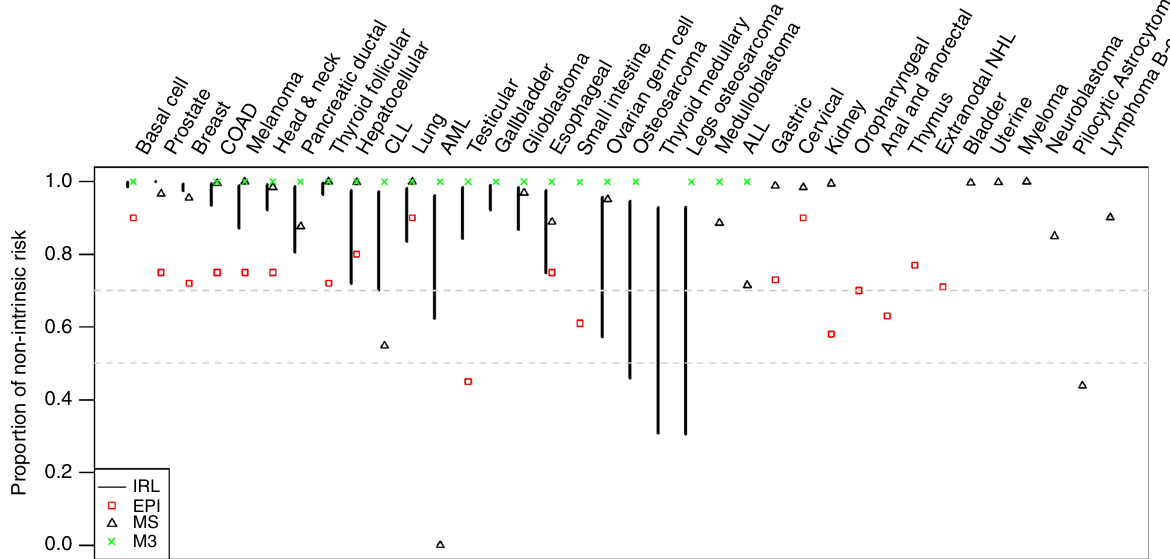
Fig. 4 Proportion of non-intrinsic risk estimates from four different approaches. Data were obtained from ref 15 . The two dashed horizontal lines indicate non-intrinsic risk at the levels of 0.5 and 0.7. IRL con fi dence interval from the intrinsic risk line method, EPI epidemiological estimates, MS estimates based on mutational signatures (Box 1), M3 estimates from the 3-hit model, AML: Acute Myeloid Leukemia, ALL: Acute Lymphocytic Leukemia, CLL: Chronic Lymphocytic Leukemia, NHL: Non-Hodgkin ’ s Lymphoma. Most cancers show substantial non-intrinsic risks, except for AML, ALL, CLL and Pilocytic Astrocytoma, all of which are rare cancers and contribute less than 1% of the total cancer burden, and therefore those results do not affect our overall estimates. Moreover, AML, ALL and CLL are blood cancers whose pathogenesis and requirement for mutations may differ from solid